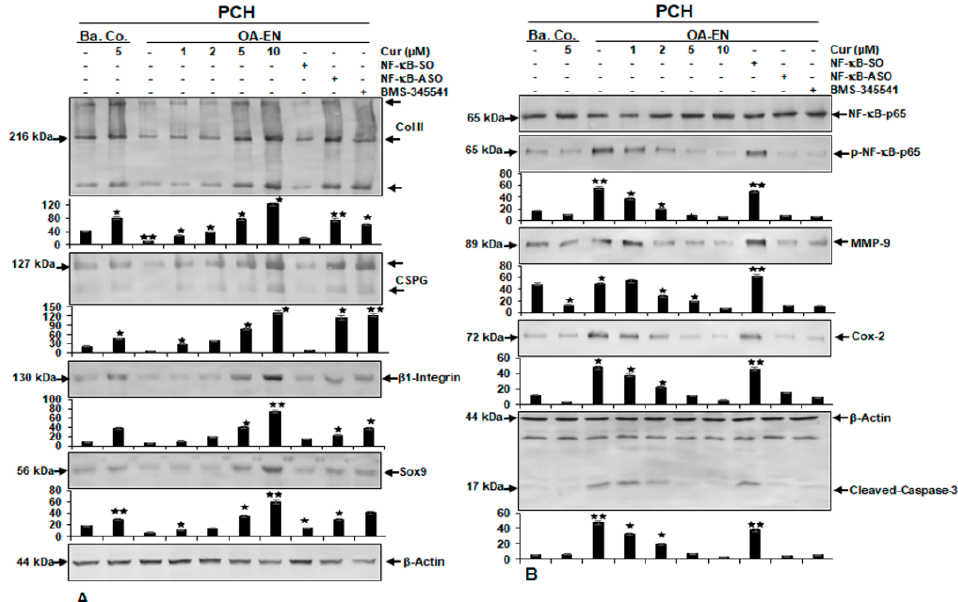
Figure 4. Influence of curcumin, ASO against NF-kB, BMS-345541 upon extracellular matrix, β 1- integrin, Sox9, NF-kB, NF-kB-promoted pro-inflammatory, matrix-degrading, and apoptotic proteins on chondrocytes in the osteoarthritic environment. Panel A-B: Serum-depleted chondrocytes (PCH) in alginate cultures by themselves (Ba. Co.) were kept nontreated or treated with curcumin (Cur), or co-cultured with fibroblasts and T-lymphocytes (OA-EN) and kept nontreated or treated with different doses of curcumin, or transfected with NF-kB-SO or NF-kB-ASO or treated with BMS-345541 for 14 days as outlined in Materials and Methods. Total cell samples were obtained, separated via SDS-PAGE, and subjected to western blot assay with antibodies against panel A: Collagen II, CSPG, β 1-integrin, Sox9 panel B: NF-kB, phospho-NF-kB, MMP-9, Cox-2, and activated Caspase-3. β -Actin served as a loading control in each assay. Bars represent the mean values for each antibody along with standard variations of at least three separate experiments. Data were compared to the control. (cid:70) (cid:70)(cid:70) Statistically meaningful levels of p < 0.05 are marked with ( ) and p < 0.01 with (